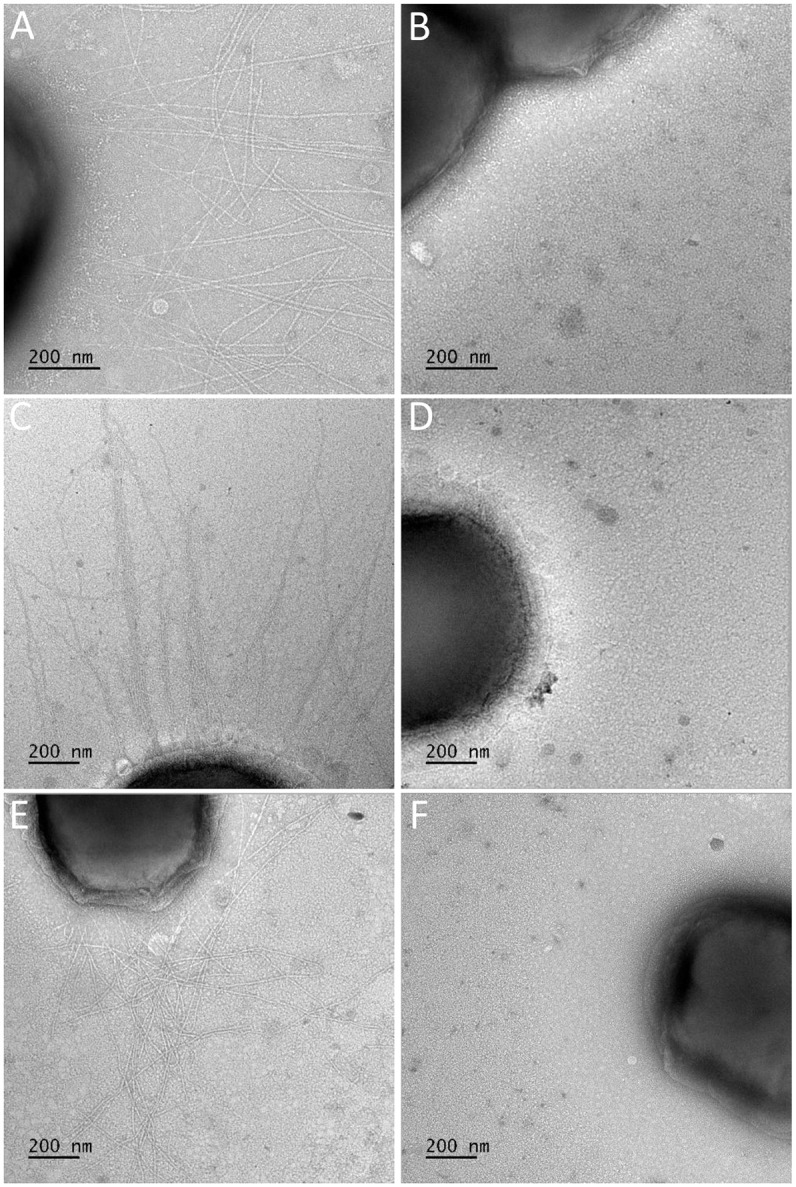
K. negevensis produce surface fibers.Strains BB526 (A), BB526pilA (B), Sch1437 (C), Sch1437pilA
(D), D2292 (E), and D2292pilA
(F) were negatively stained and visualized using TEM. Abundant long surface fibers are present on the surface of the wild type strains BB526, Sch1437, and D2292 but are absent from the surface of each isogenic pilA mutant.